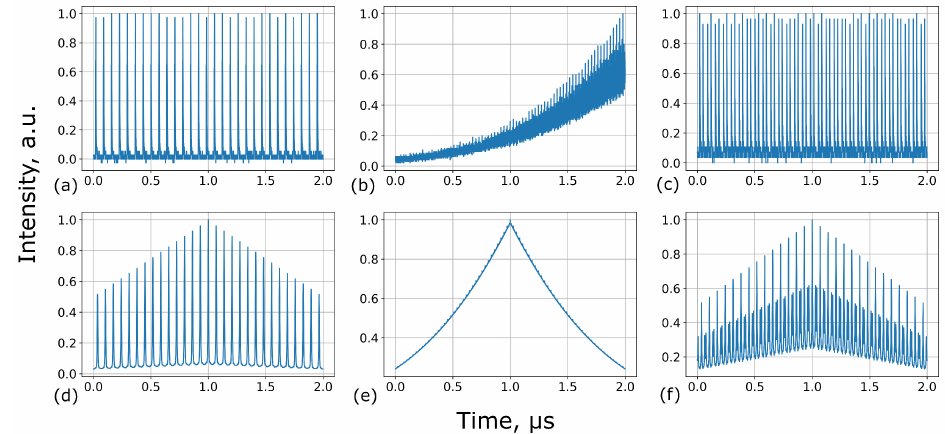
Figure 3. ( a – c ) Oscilloscope traces of stable single-pulsed regime; unstable, Q-switched, mode-locked regime; stable double-pulse regime. ( d – f ) Corresponding autocorrelation functions of the